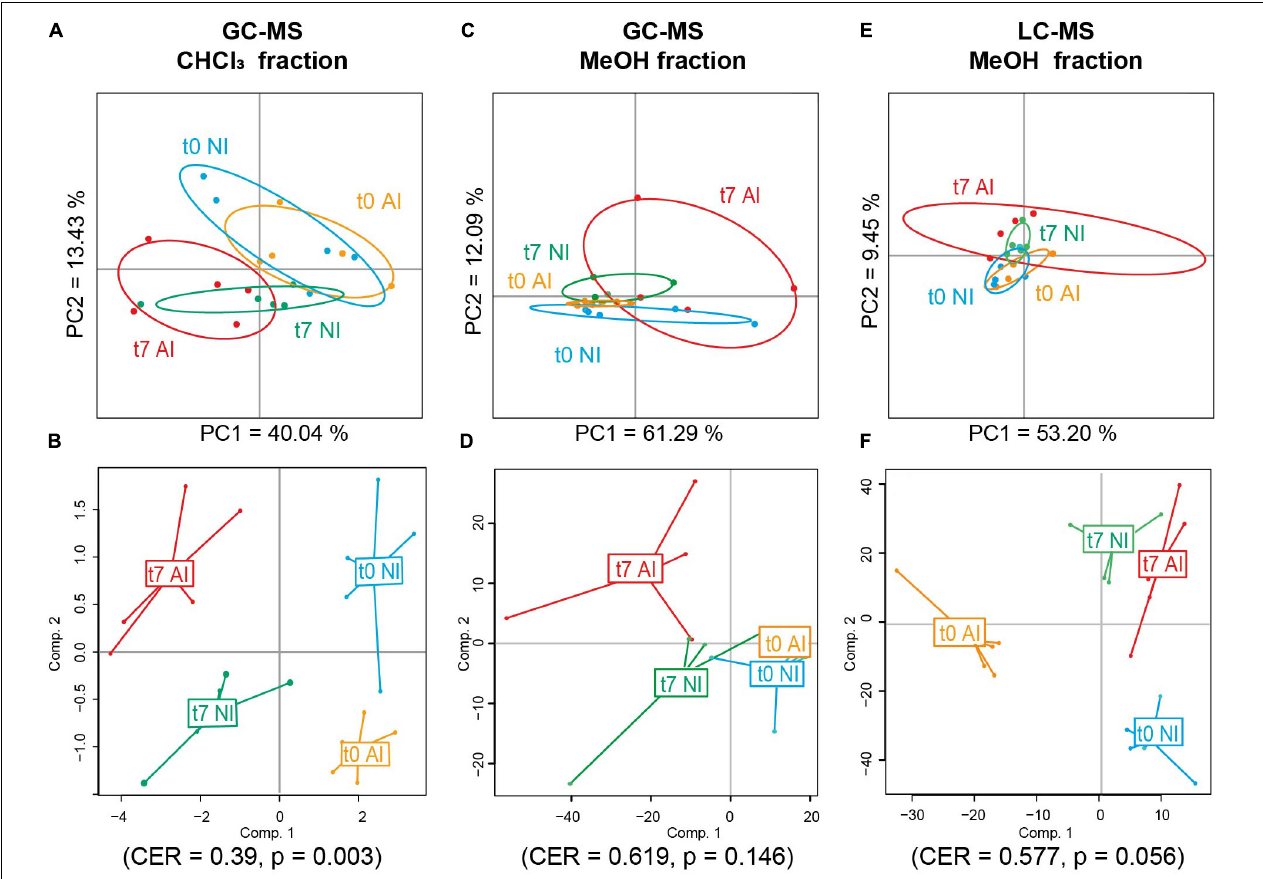
FIGURE 4 | Metabolomic fingerprint analyses of the MPB biofilm at the beginning (t0) and the end (t7) of the experiment depending of the light exposure conditions via unsupervised (Principal Component Analysis, PCA, A,C,E ) and supervised discriminant (Powered Partial Least-Squares-Discriminant Analysis, PPLS-DA, B,D,F ) analyses. The metabolome was analyzed by (A,B) GC-MS for CHCl 3 fractions, (C,D) GC-MS for MeOH fractions, and (E,F) LC-MS for MeOH fractions (NI: natural irradiance; AI: higher artificial irradiance). CER, classification error rate with p -value after double cross model validation.